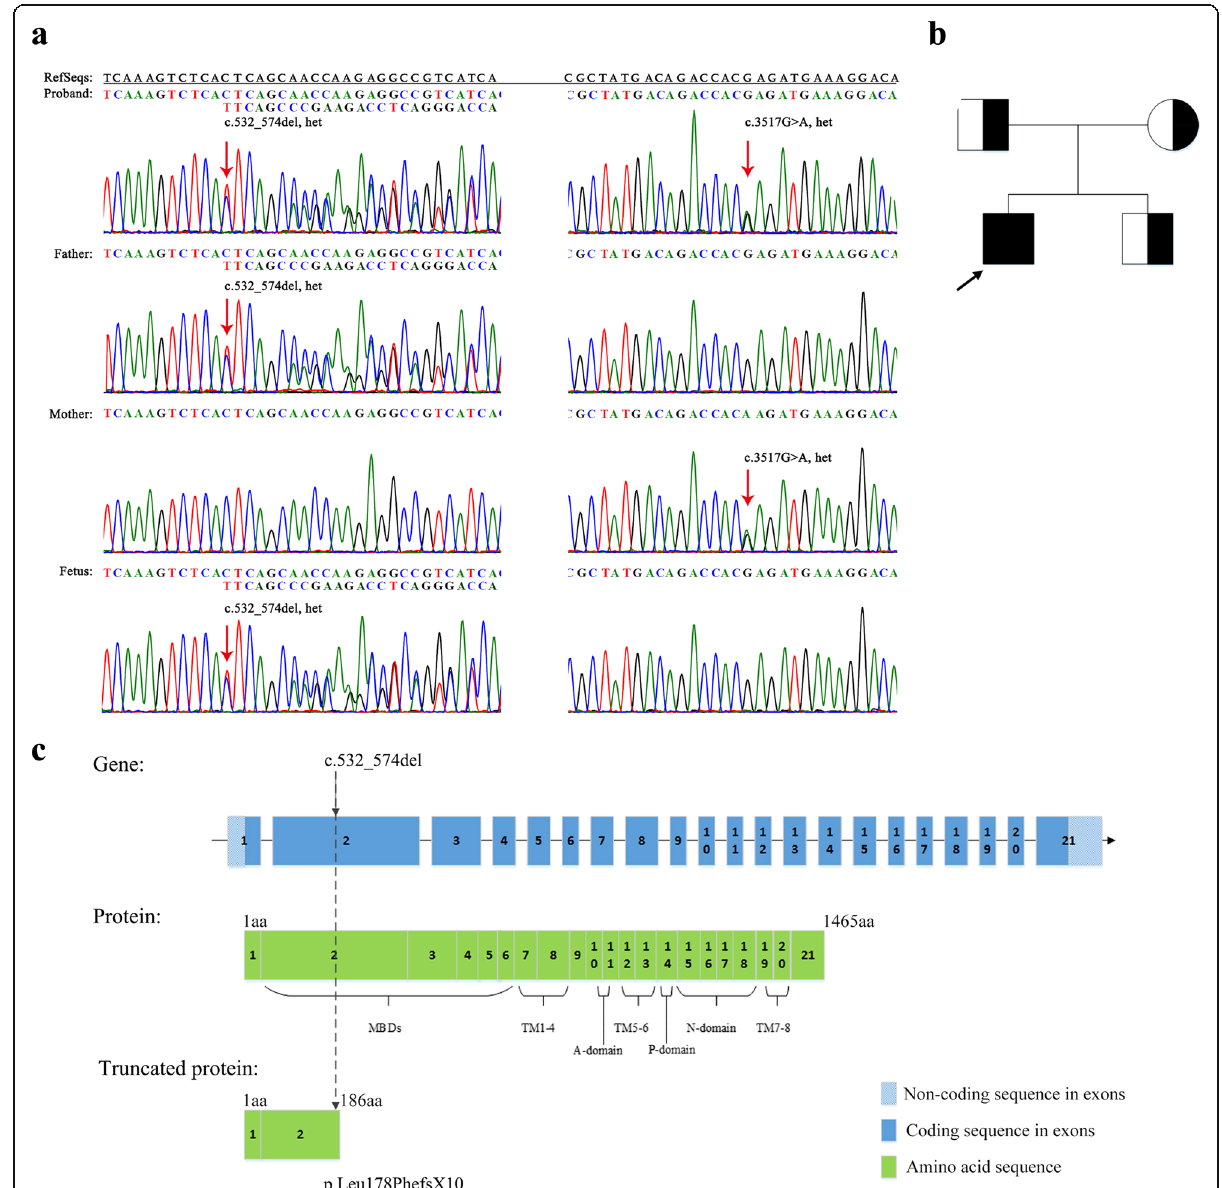
Fig. 1 Detection of a novel deletion mutation in the ATP7B in a WD patient: c.532_574del (p.Leu178Phefs*10). a The compound heterozygous mutation was found in the proband by direct Sanger sequencing. The novel deletion mutation was inherited from his father, and the other reported c.3517G>A (p.Glu1173Lys) mutation was inherited from his mother. The second fetus of the couple had just the heterozygous c.3517G>A mutation. Red arrow, changed base. b The pedigree was in line with the typical Mendelian inheritance of autosomal recessive genetic diseases. Black arrow, proband. c Illustrative explanation of the deletion mutation affecting ATP7B protein structure and composition. The 43-bp deletion results in a frameshift mutation to produce a truncated protein with 1279 amino-acid residues deleted at the C-terminus, compared with 1465 amino-acid residues in the normal ATP7B protein. Dashed arrows, changed position. MBDs, N-terminal metal-binding domains, including six copper binding domains; TM1 – 8, eight transmembrane domains building the transmembrane channel for copper transport; A-domain, a phosphatase domain or transduction domain where acyl-phosphate is dephosphorylated, performing ATP hydrolysis for copper cation transport; P-domain, a phosphorylation domain for Asp phosphorylation from the DKTGT sequence; N-domain, an ATP- or nucleotide-binding and triplex structures, respectively, were not found in observed in the 193-nucleotide sequence using Fuzz- the above sequence by RepeatAround. The QGRS nuc. No motifs forming left-handed Z-DNA were pre- software revealed oligo(G)n tract forming tetraplex dicted by nBMST. Direct, inverted, and mirror structures in the above nucleotide sequence. repeats capable of forming slipped hairpin, cruciform,